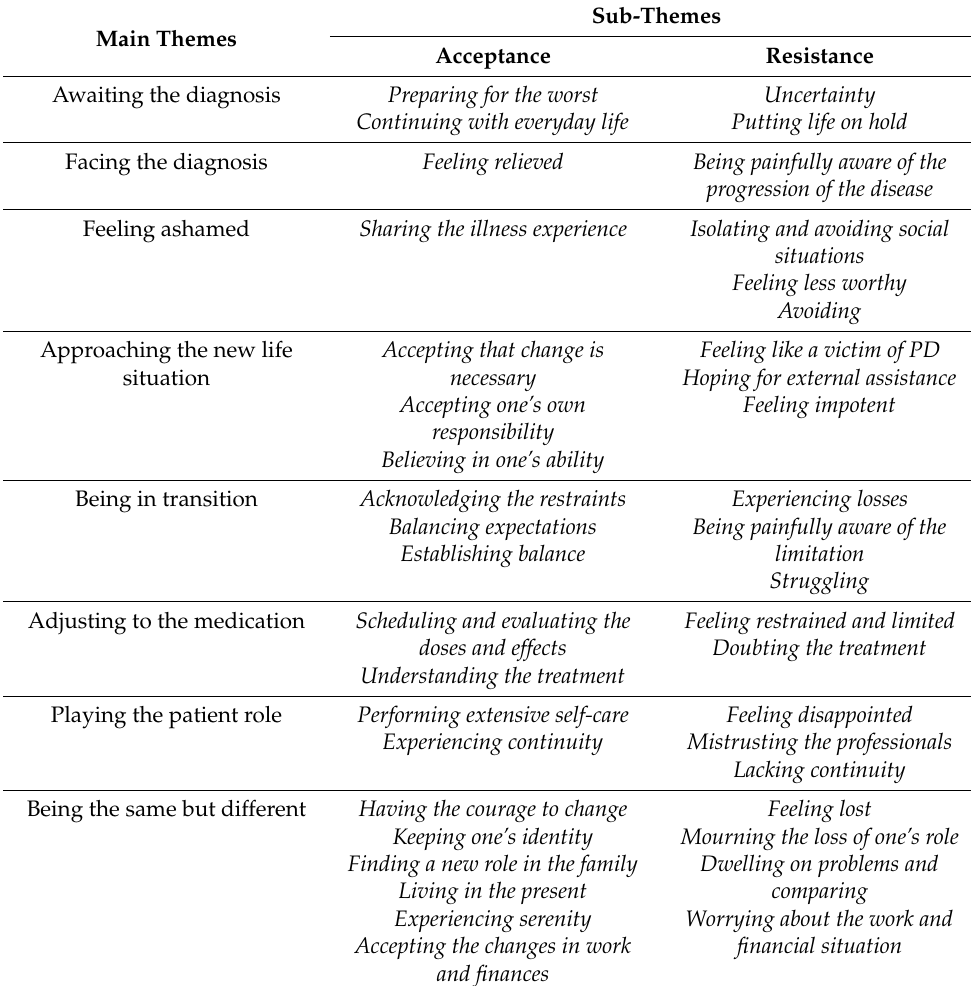
Table 2. Structural analysis of the meaning of adapting to Parkinson’s